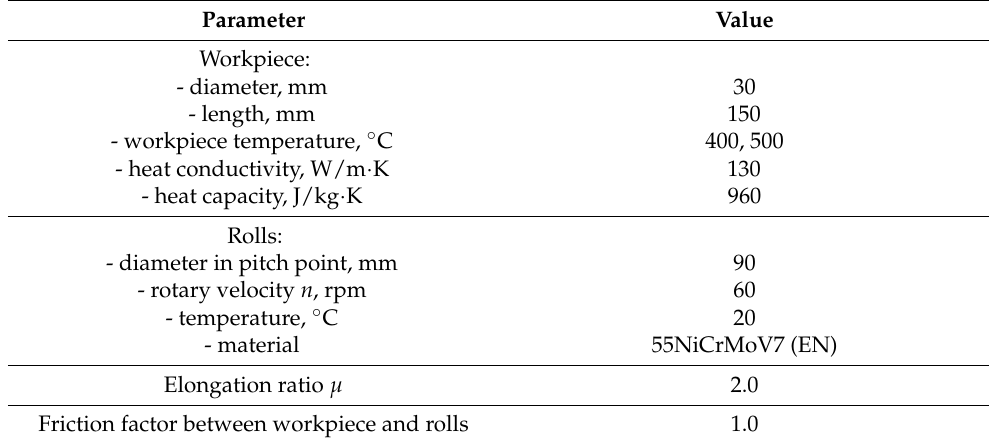
Figure 2. 3D model for simulation ( a ) and scheme of roll angles for the RSR process ( b ). The main parameters given in the pre-processor program are presented in Table 1. Table 1. Parameters of model for simulation of RSR process.